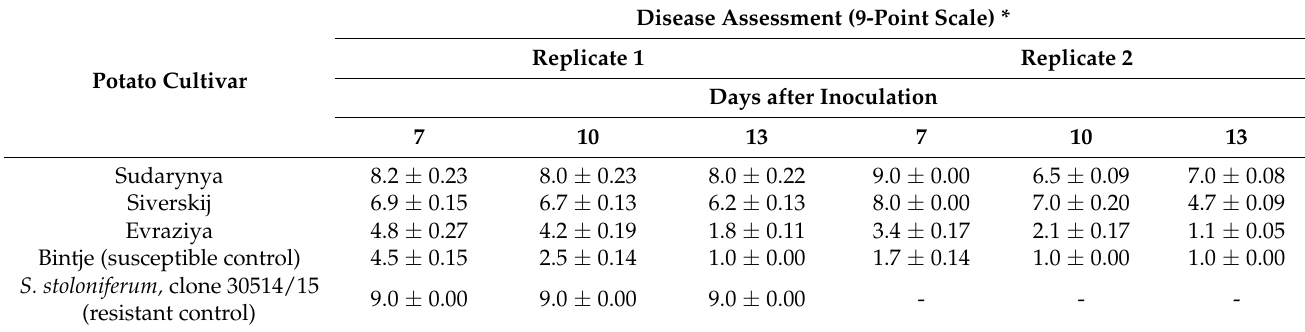
The multidimensional scaling analysis demonstrates that libraries of the same geno- type and conditions are clustered on the MDS plot (Figure 1). The transcriptomes corre- sponding to control (0 hpi) and P. infestans infection (24 hpi) were clustered separately. As